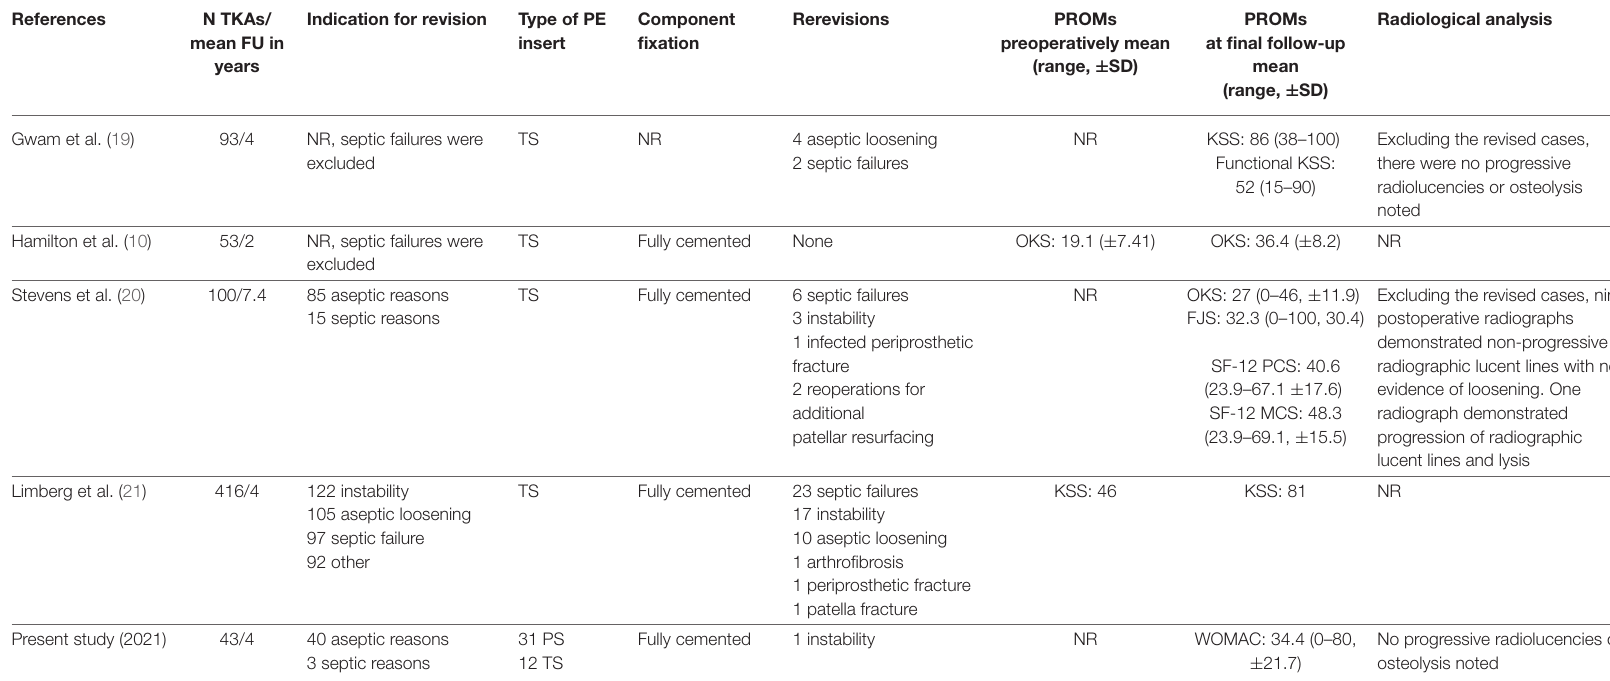
TABLE 7 | Results of studies reporting their outcomes with the Triathlon TS Knee System (Triathlon Total Knee System; Stryker Orthopedics, Mahwah, NJ) for revision